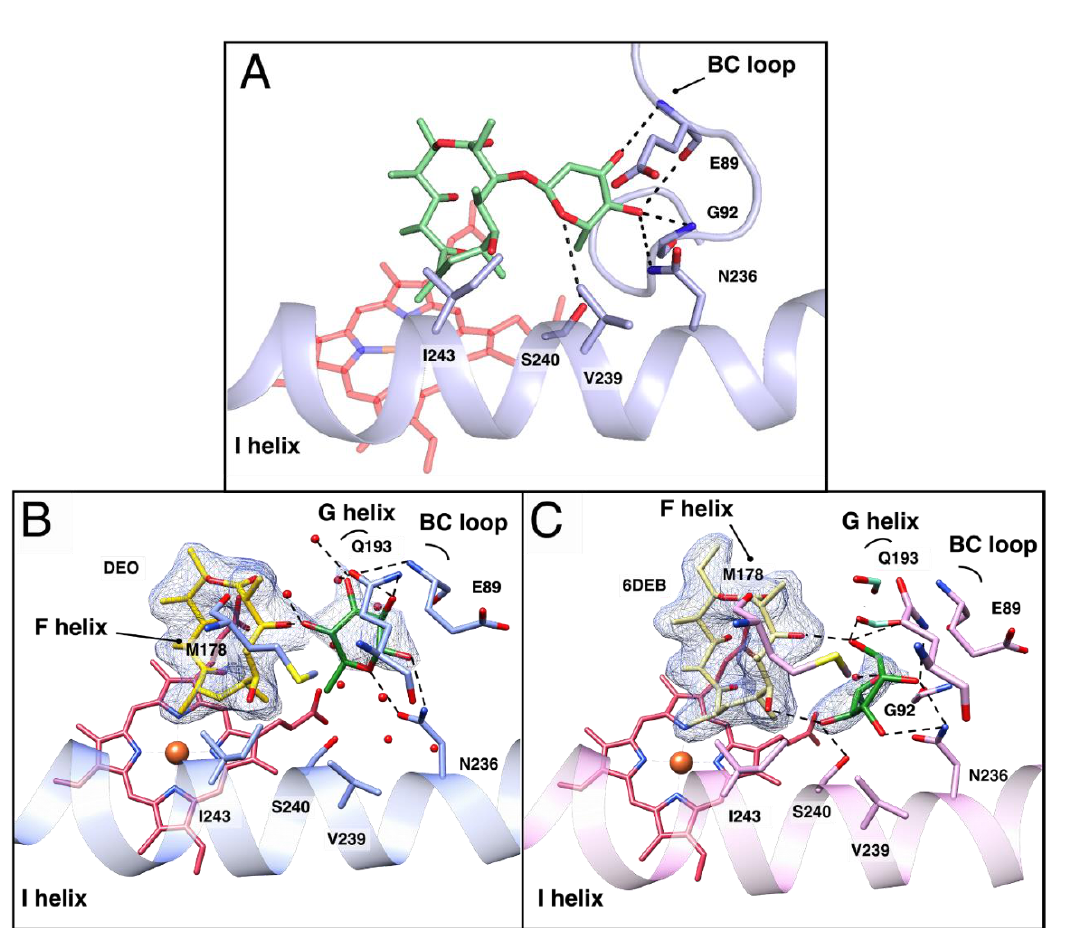
Figure 4. In silico docking of L-O-DEO and structures of OleP-aglycones bound to L-rhamnose. ( A ). Zoom on the active site of closed OleP (blue) into which L-O-DEO (lime green sticks) was computationally docked using AutoDock Vina 1.1.2. Residues forming direct hydrogen bonds (dashed lines) with the olivosyl moiety of L-O-DEO, placed at a distance ranging between 2.4 and 4 Å, are labeled. ( B , C ). Close up views of the active site OleP–DEO-rhamnose (panel B , blue) and OleP–6DEB–rhamnose (panel C , pink). Residues and solvent molecules (water, red spheres; formate ions, aquamarine sticks) within 5 Å from L-rhamnose are displayed. Dashed lines represent hydrogen bonds. Secondary structural elements and amino acids are labeled. In both panels, the electron density map (2F o –F c ) contoured at 1 σ around L-rhamnose (green sticks) and DEO (yellow sticks, panel B ) or 6DEB (khaki sticks, panel C ) is shown as a blue mesh.